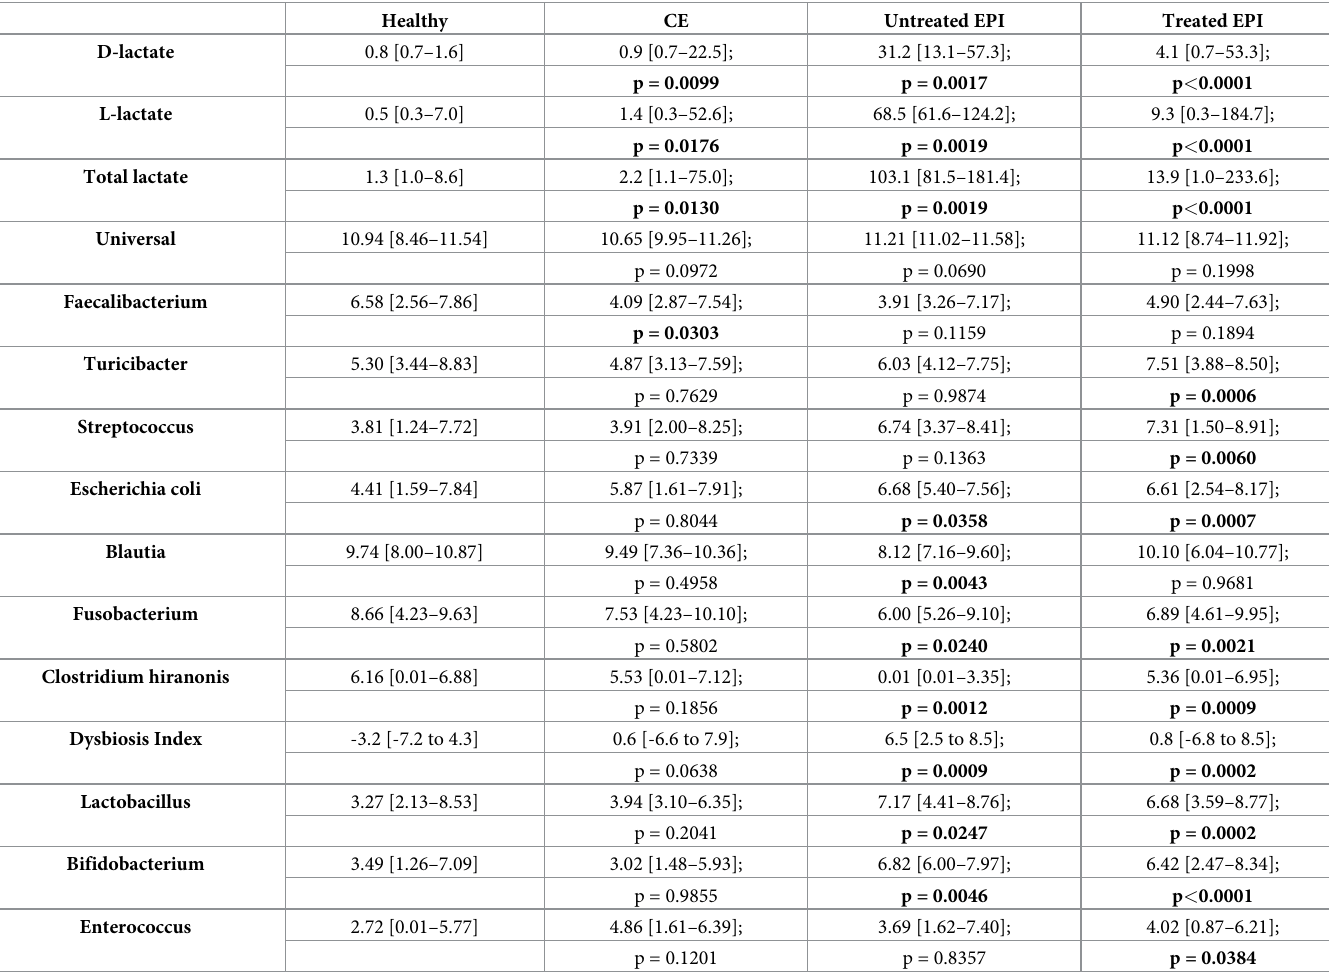
Table 3. D-, L-, and total fecal lactate concentrations (median [min-max] mM), abundance of bacterial groups (median [min-max] LogSQ), and Dysbiosis Index (median [min-max]) in diseased dogs compared to healthy control dogs with Steel-Dwass